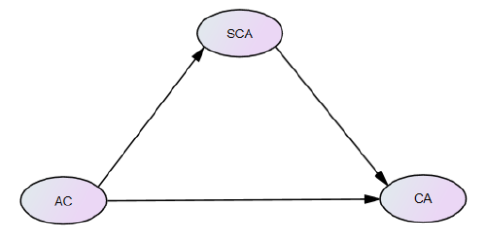
Figure 1: Research Model; Source: Data Processed